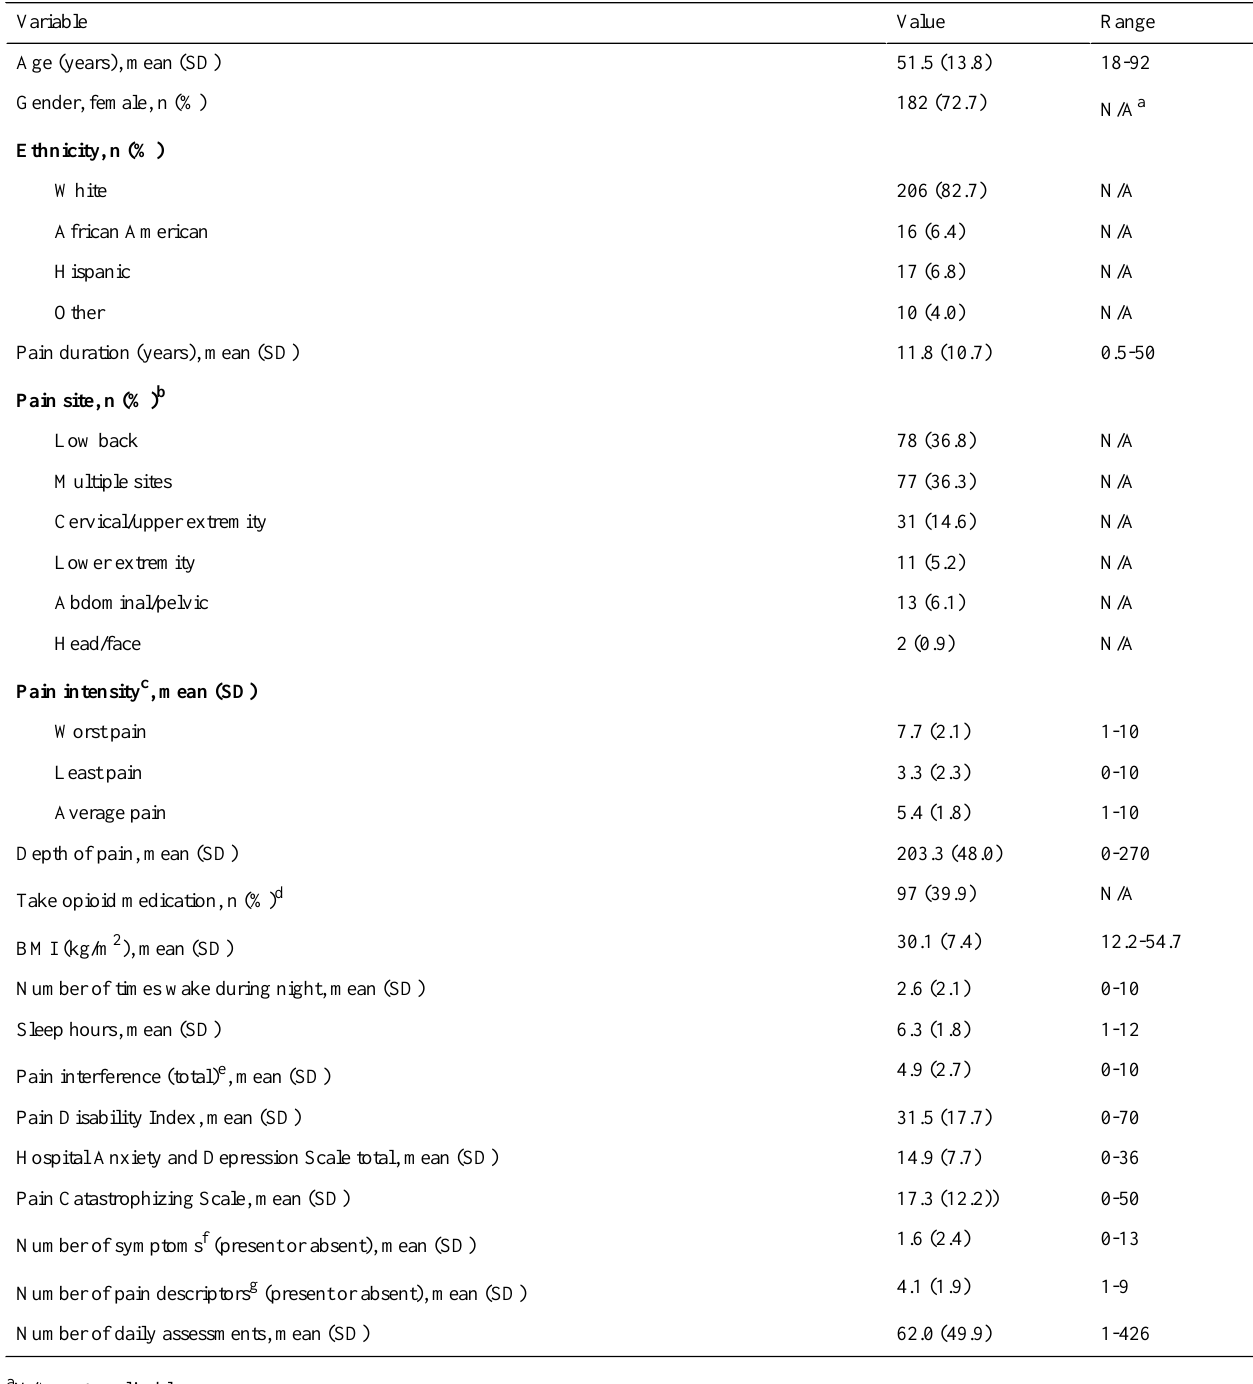
Table 1. Patient demographic characteristics